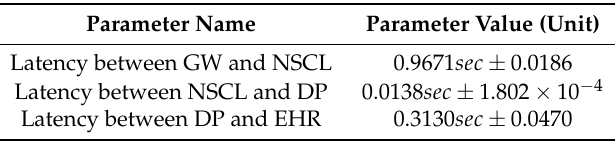
Table 2. Latencies In EHM